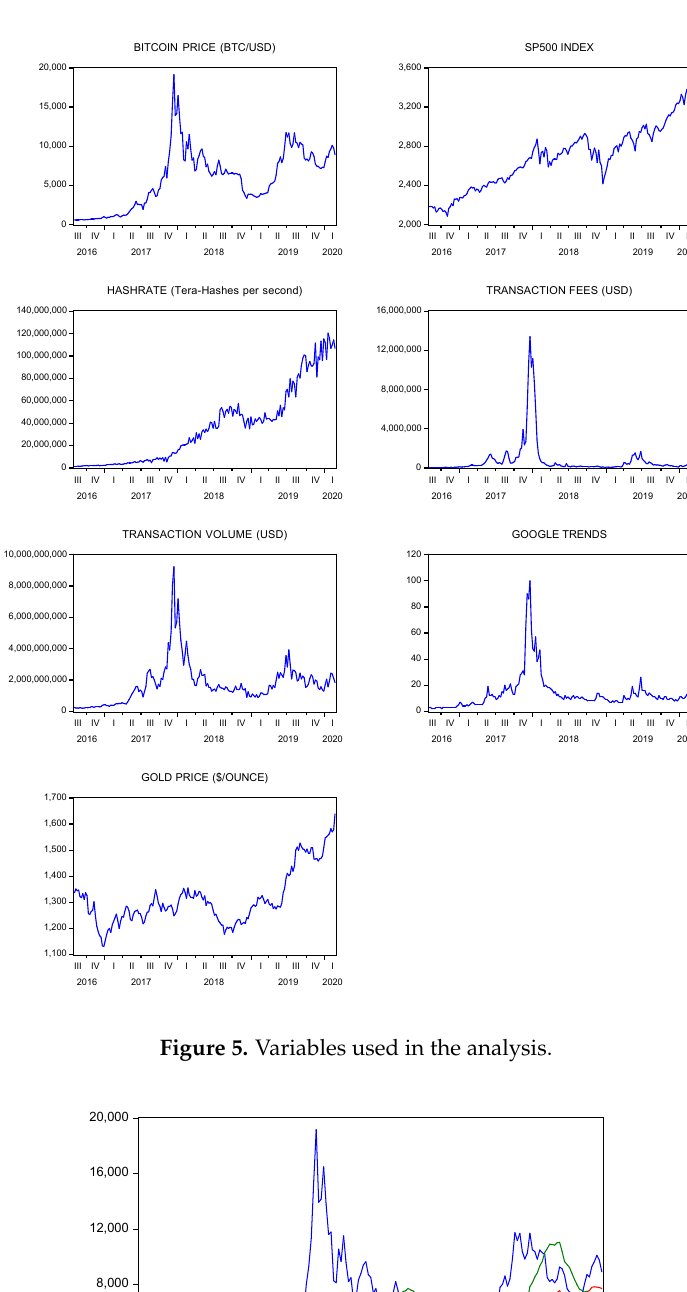
Figure 5. Variables used in the analysis.